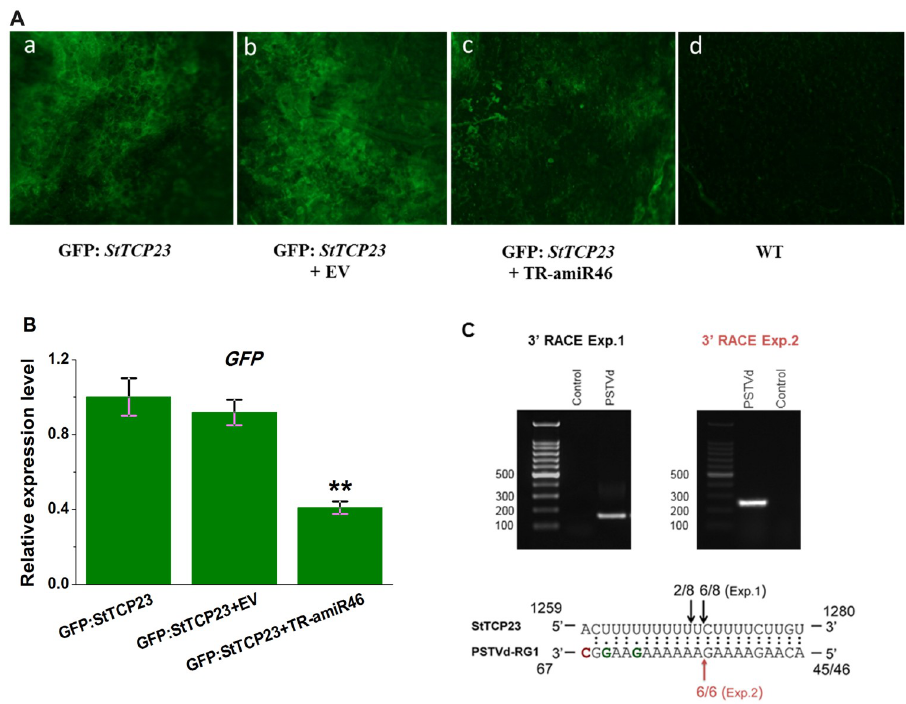
Fig 4. Predicted targeting of the StTCP23 mRNA by vd-sRNA. (A) Potato leaves were agroinfiltrated with transient vector expressing (a) GFP: StTCP23 , (b) GFP: StTCP23 plus empty vector, (c) GFP: StTCP23 plus TR-amiR46, (d) wild type control. At 5 dpi the leaves were photographed (4X) using a fluorescence microscope. (B) Potato leaves were agroinfiltrated using the same plasmid combinations as in (A). At 5 dpi relative GFP expression was quantified by RT- qPCR. (C) Nested PCR products obtained from 3 0 RACE Exp.1 and 3 0 RACE Exp.2, using primers targeting the StTCP23 mRNA were separated by 2.0% agarose gel electrophoresis. Predicted structure of the StTCP23 mRNA/vd- sRNA duplex formed by siRNAs derived from the PSTVd-RG1. Arrows indicate the 3 0 termini of StTCP23 mRNA fragments isolated from the PSTVd-infected plants, as identified by 3 0 RACE Exp.1 and by 3 0 RACE Exp.2, with the frequency of each termini shown.